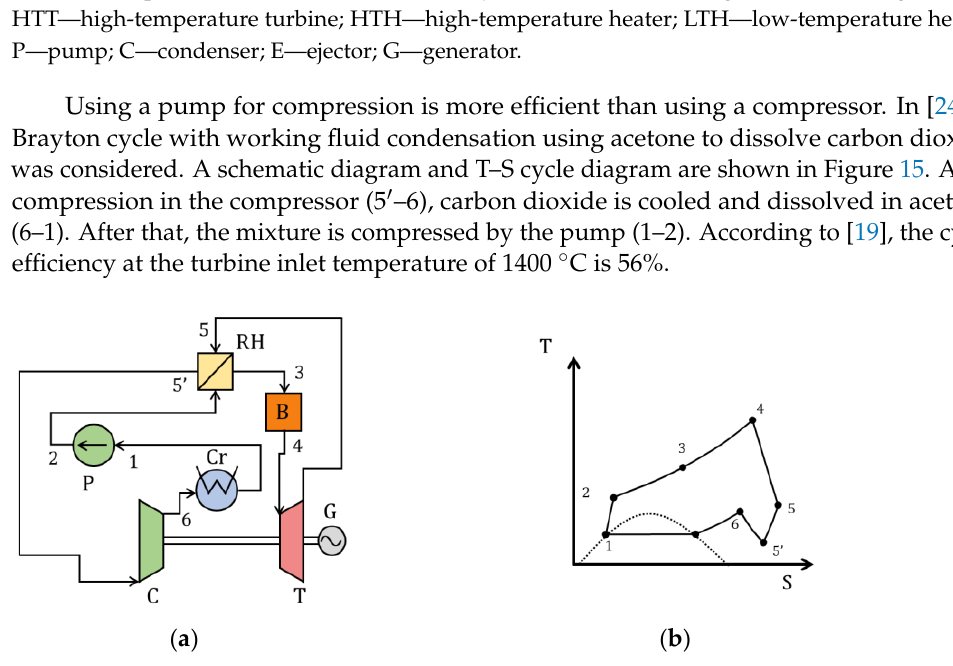
Figure 15. Supercritical CO 2 Brayton cycle with acetone absorption: ( a ) schematic diagram; ( b ) T – S diagram [24]. B — boiler; T — turbine; C — compressor; Cr — condenser; P — pump; RH — regenerative heat exchanger; G — generator.